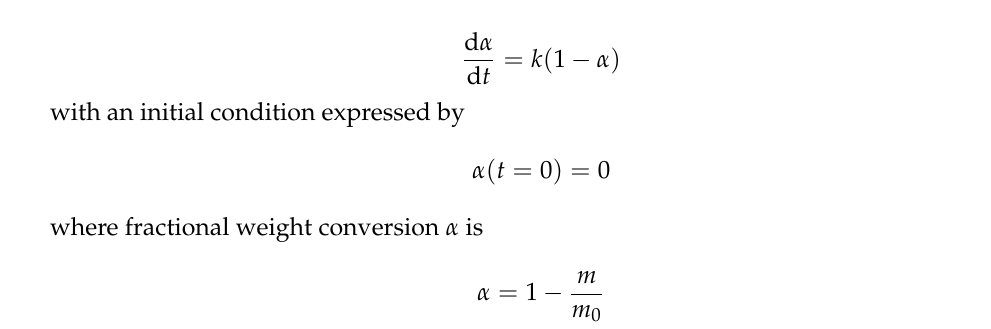
, T DSC , and temperature of devolatilization onset T inVM ign 1 ign 2